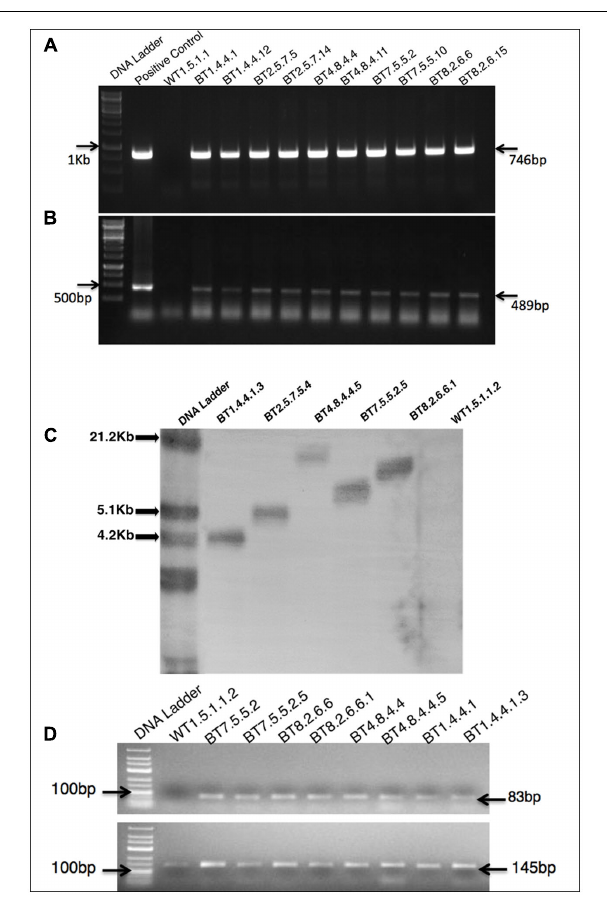
FIGURE 2 | Molecular biology characterizations of transgenic plants. PCR analysis of T 3 transformants, showing partial amplification of (A) 746 bp cry1Ab/Ac gene (B) 489 bp hpt gene. (C) Southern blot analysis of genomic DNA of T 4 plants digested with Nco I and probed with DIG labeled 746 bp of cry1Ab/Ac showing single copy integration. (D) RT-PCR analysis of T 3 and T 4 plants of a same transgenic line showing 83 bp amplification of cry1Ab/Ac gene in transgenic plants and 145 bp 26S rRNA gene (internal control) in all plants.